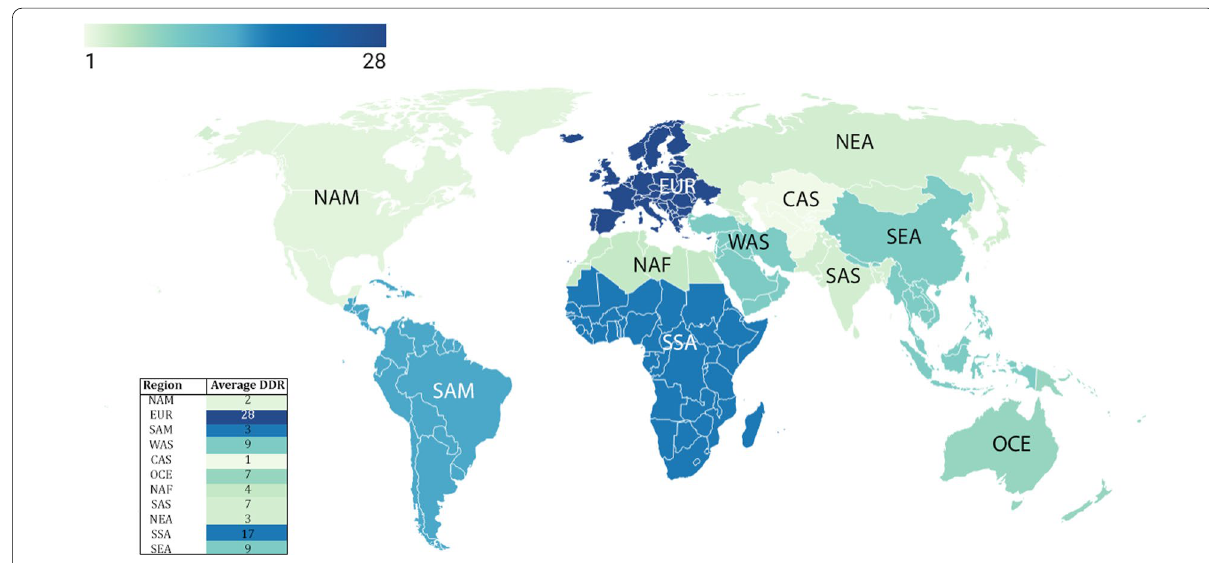
Fig. 1 The frequency of the